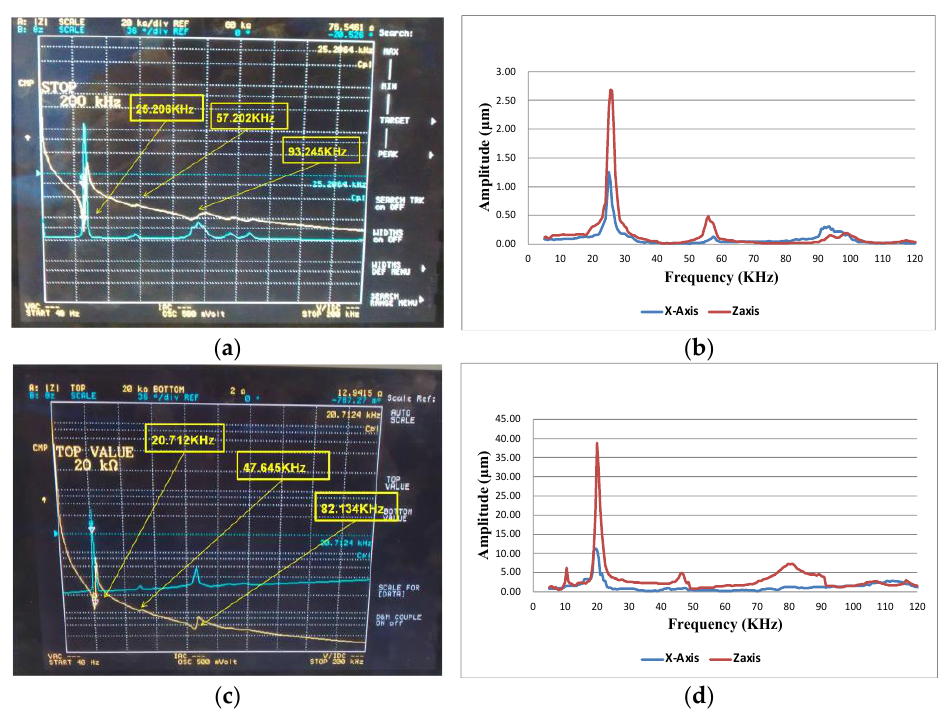
Figure 11. ( a ) The frequency, impedance and phase analysis; ( b ) the displacement–frequency response diagram of the multi-layer bimorph stator; ( c ) the frequency, impedance and phase analysis; and ( d ) the displacement – frequency response diagram of the simple bimorph stator.